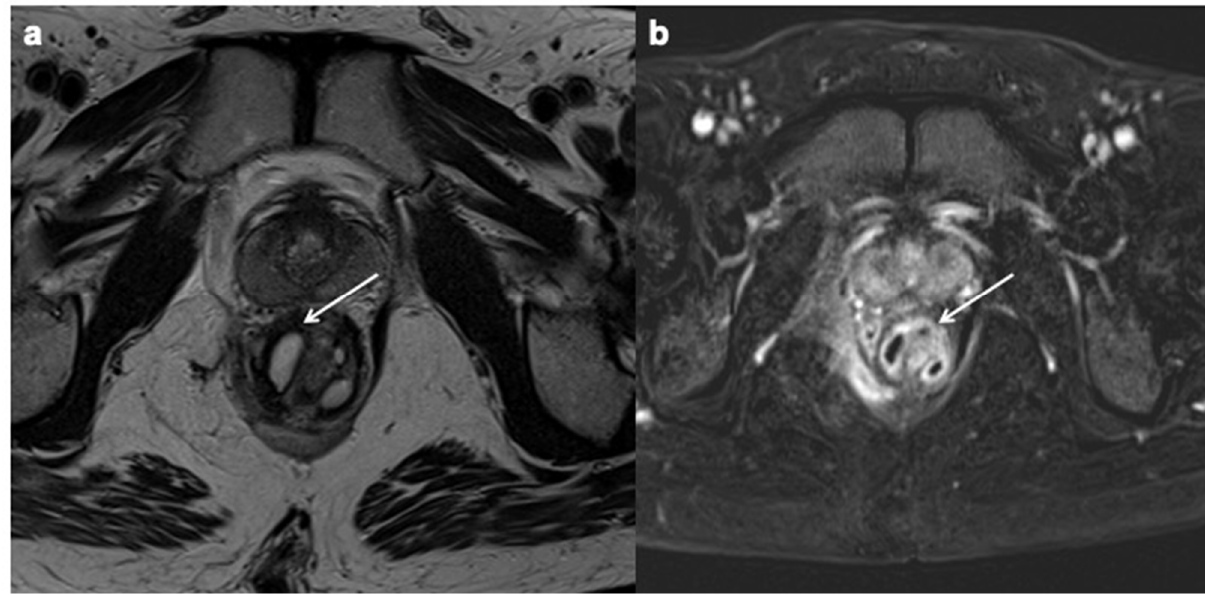
Figure 11. Perianal CD ( a , b ). Axial T2 FSE without FS and axial contrast-enhanced fat-suppressed T1 weighted enteric phase MRE images (white arrows) show a intersphinteric perianal fistula with horseshoe appearance.